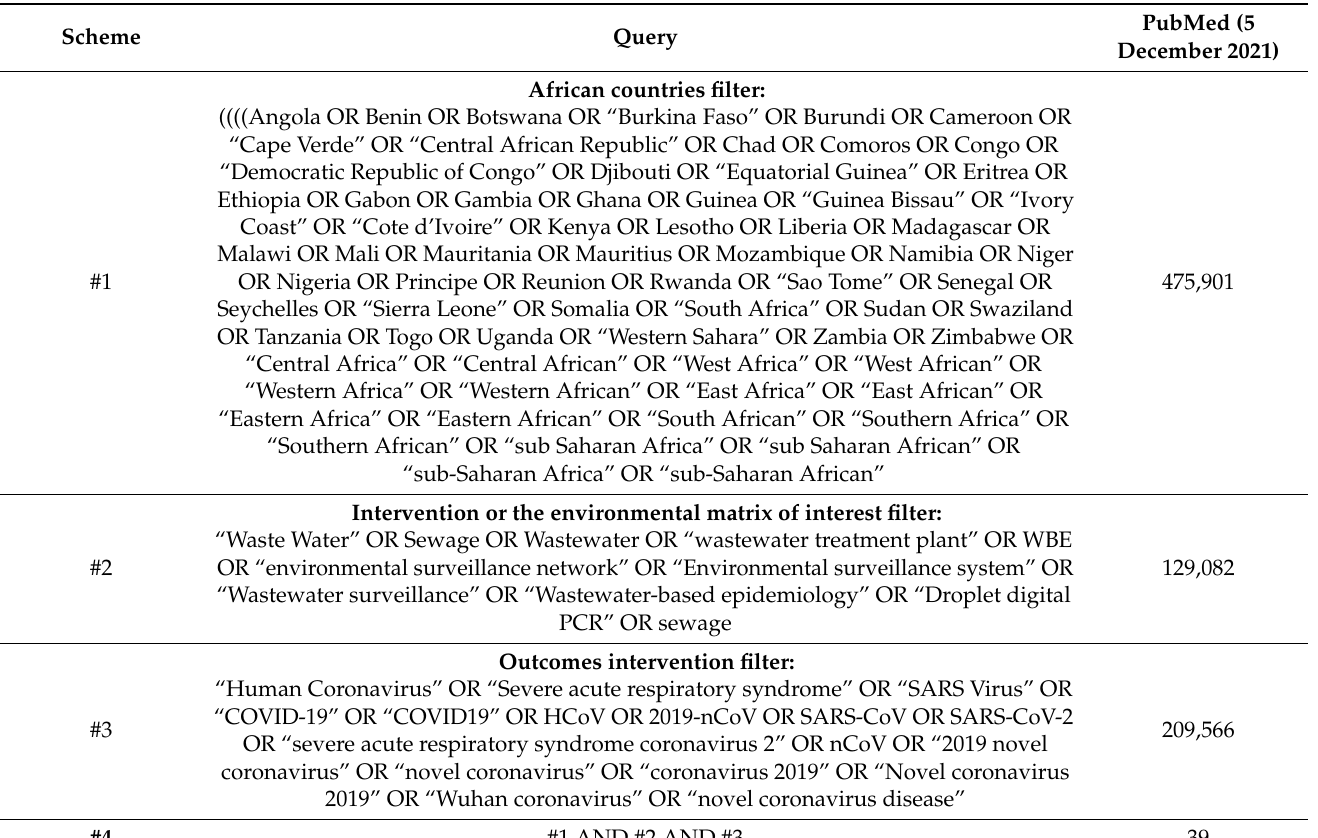
Table 1. Search strategy with articles retrieved from PubMed electronic